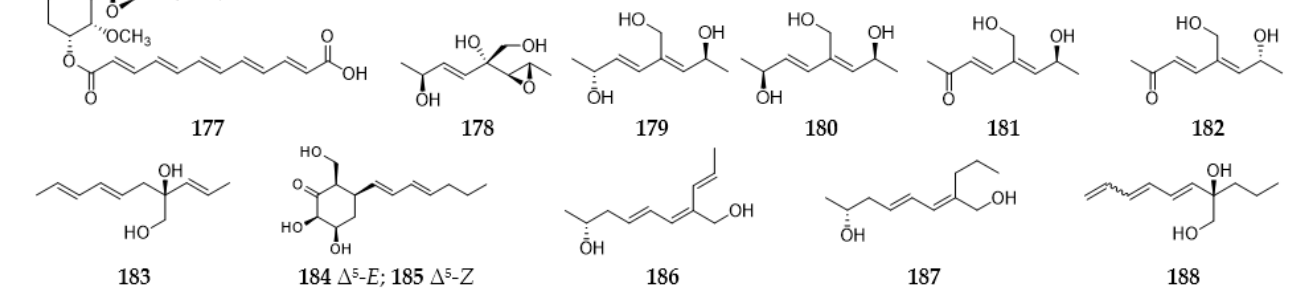
Figure 11. Aspergillus -derived polyenes ( 177 – 188